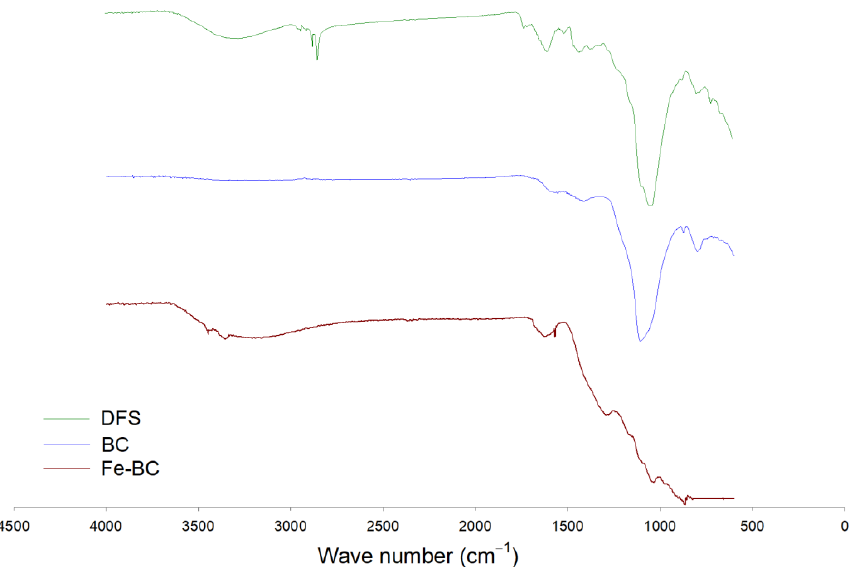
Figure 1. FTIR analysis of date palm waste (DFS), date palm waste biochar (BC), and Fe-modified biochar